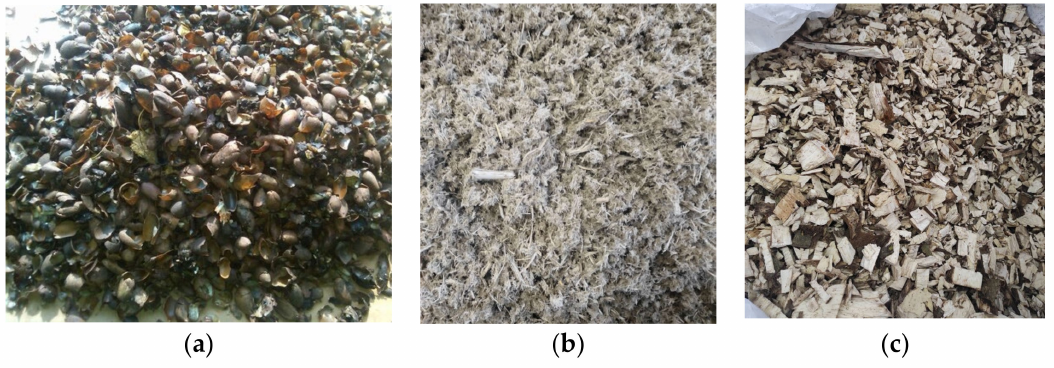
Figure 3. Examples of biomass for briquette production ( a ) agro-processing residues—breadfruit shells, ( b ) wood fibre, and ( c ) forest residues—chips from tree branches and small-diameter